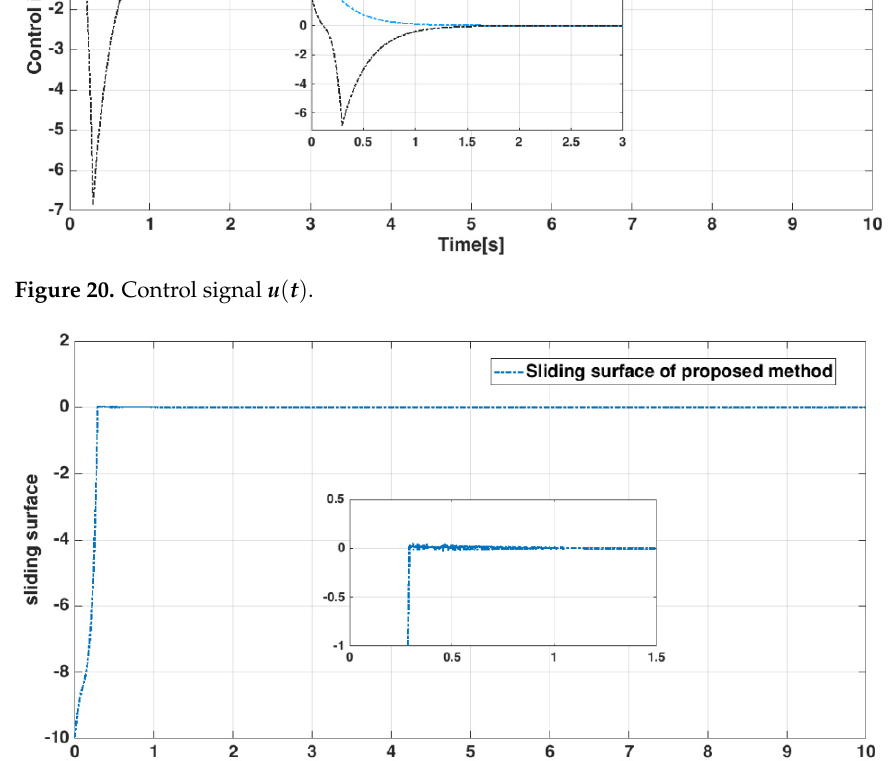
Figure 21. Integral-type terminal sliding surface 𝒔(𝒆(𝒕))